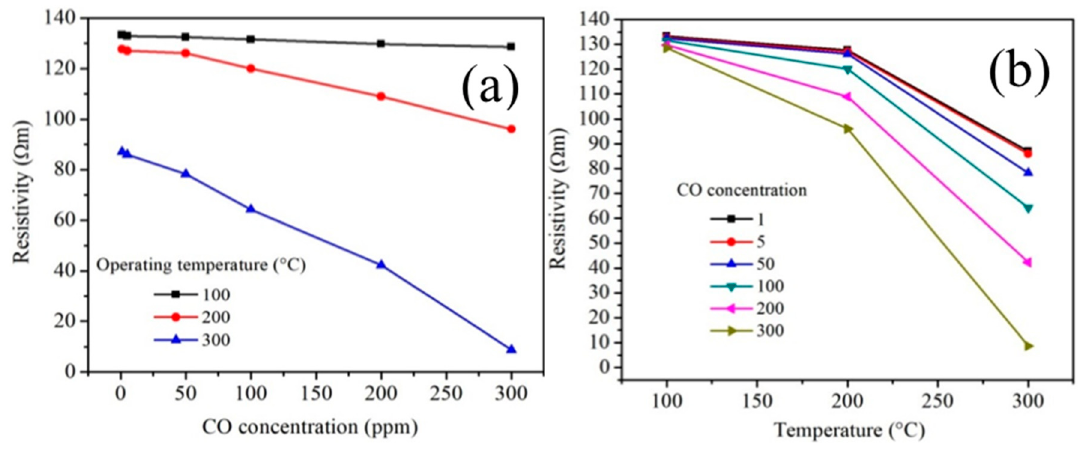
Figure 11. Electrical resistivity of the MnSb 2 O 6 pellets as a function of ( a ) CO concentration and ( b ) operating temperature.